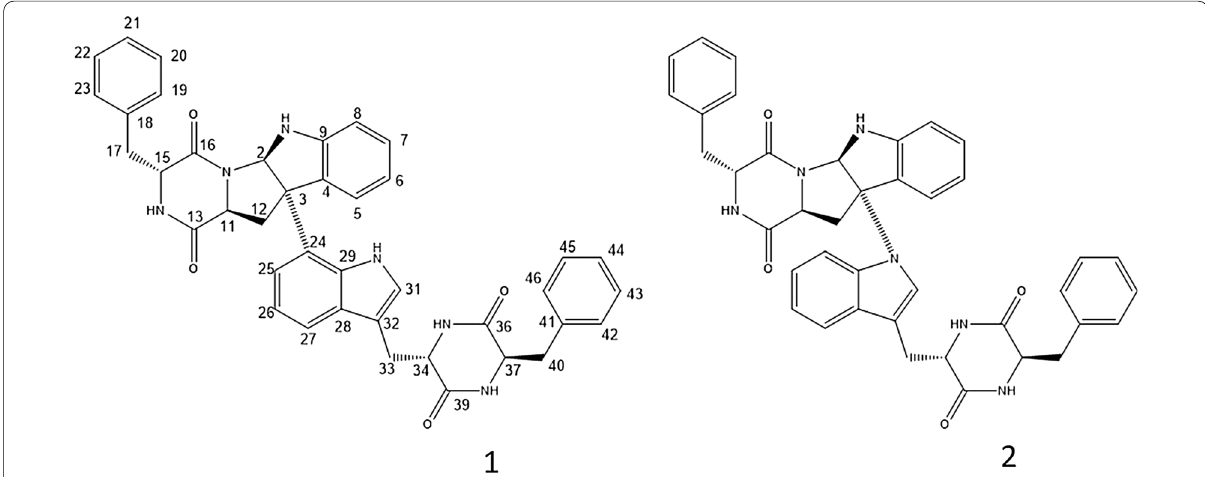
Fig. 1 Chemical structures of asperazine (1) and asperazine A